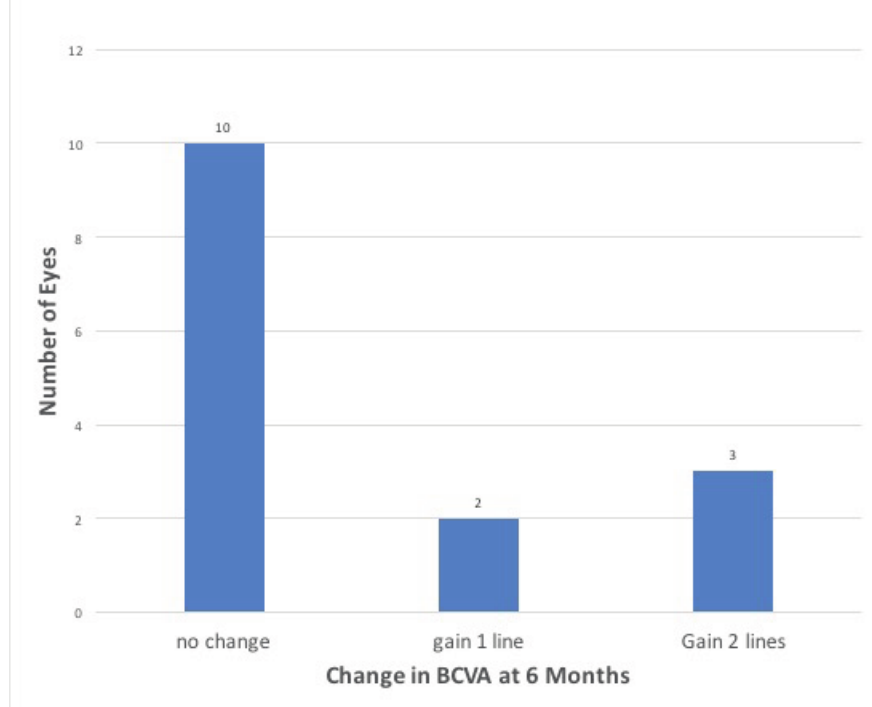
Figure 2. Change in best corrected visual acuity (BCVA). Change in BCVA preoperatively versus six months